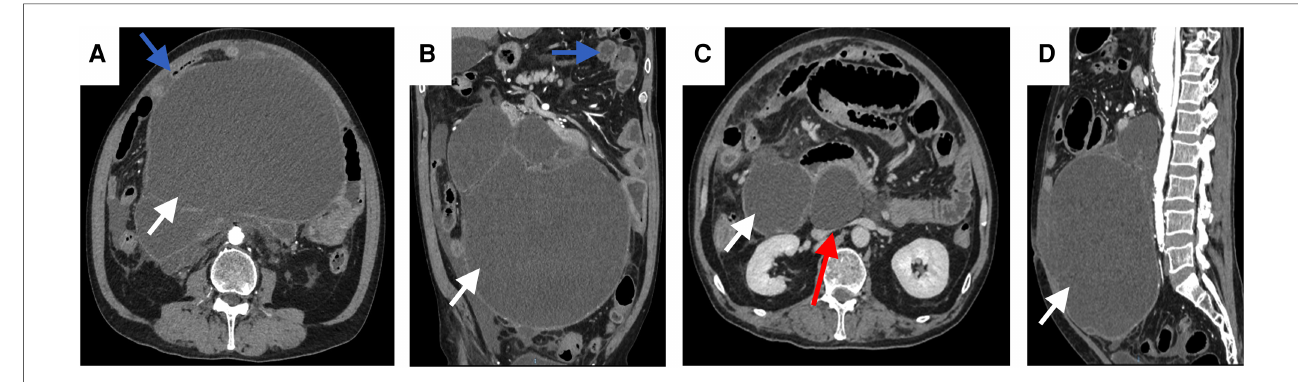
FIGURE 1 Abdominal enhanced CT axial arterial phase ( A ), coronary arterial phase ( B ), axial venous phase ( C ),and sagittal arterial phase ( D ) CT images show a retroperitoneal cystic mass (white solid arrow), extending along the mesentery to 24 cm. The tumor oppresses the surrounding intestine (blue solid arrow) and the inferior vena cava ( B ) (red solid